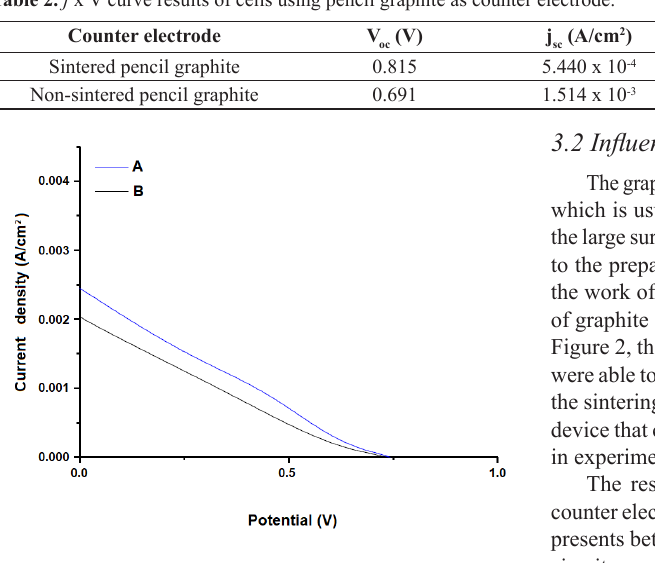
Figure 1. j x V curve of cells using FTO (A) and ITO (B) substrates. Other conditions: electrolyte: KI (0.05 M) / I / 4-tert-butylpyridine (0.05 M); Counter electrode: Graphite paste; Photoanode: TiO . 2